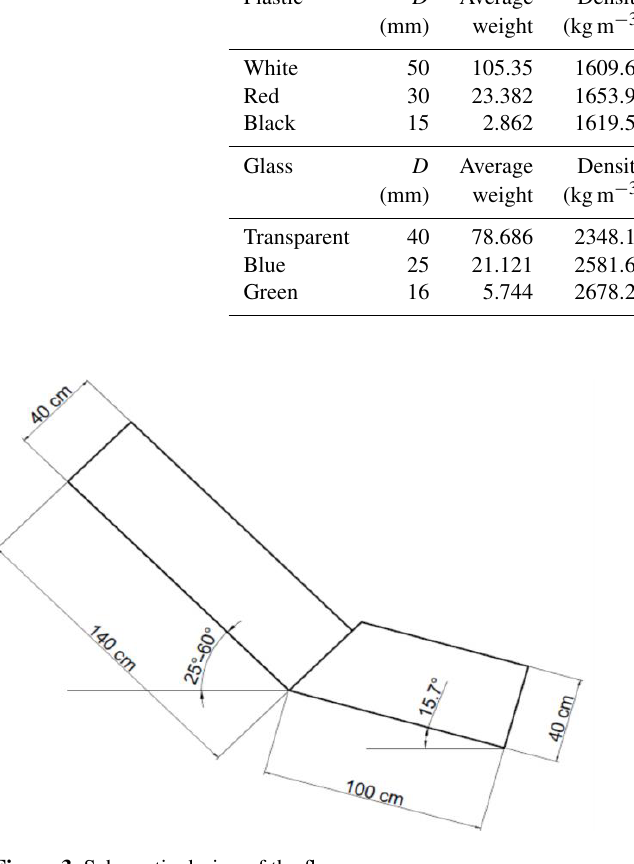
Figure 3. Schematic design of the flume.